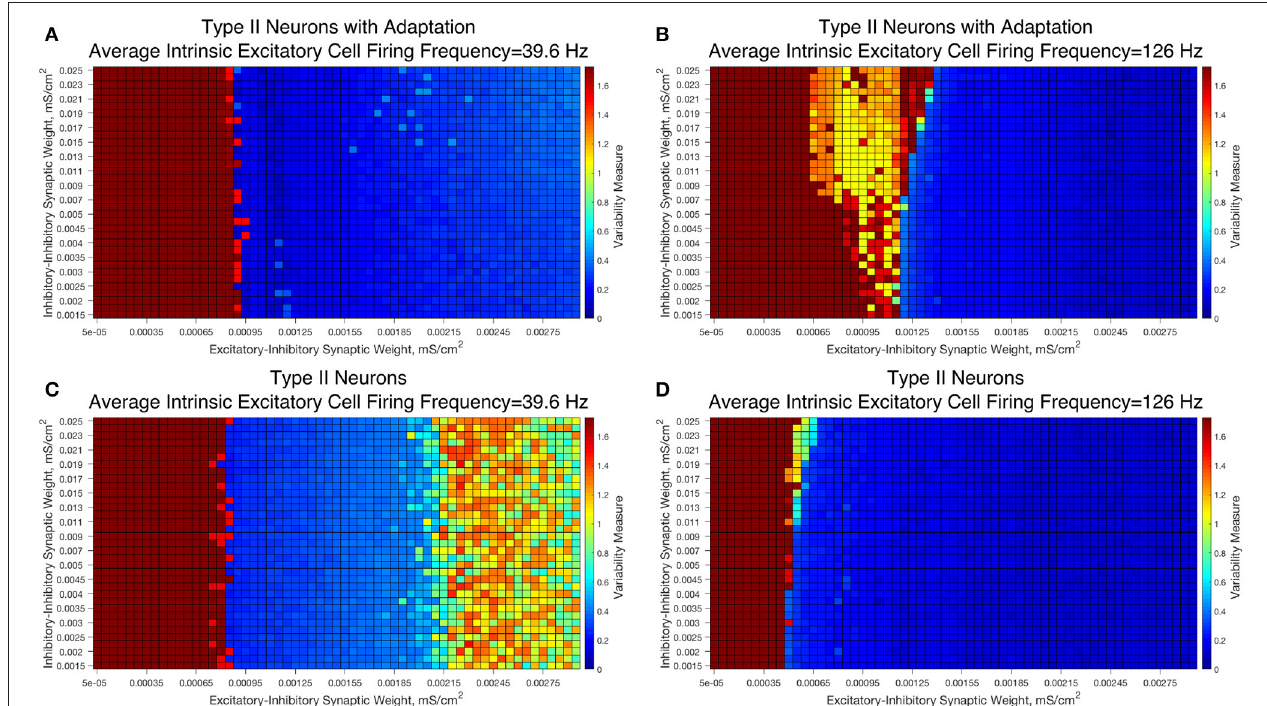
FIGURE 10 | E-I networks with Type II interneurons, both with and without an adaptation current, do not show significant change in dynamics as a function of I-I synaptic strength, unlike E-I networks with Type I interneurons. (A–D) Heatmaps showing the Variability Measure for networks with varying E-I synaptic strength on the x-axis and varying I-I synaptic strength on the y-axis. The average intrinsic cell firing frequency of the networks are set at 39.6 Hz in (A,C) and 126 Hz in (B,D) . Results with inhibitory neurons modeled as a Type II neuron with adaptation are shown in (A-B) , while results with inhibitory neurons modeled as a Type II neuron without adaptation are shown in (C,D) . Neither networks with Type II with adaptation or Type II interneurons show the significant changes in dynamics as a function of the I-I synaptic weight that typified networks with Type I interneurons.